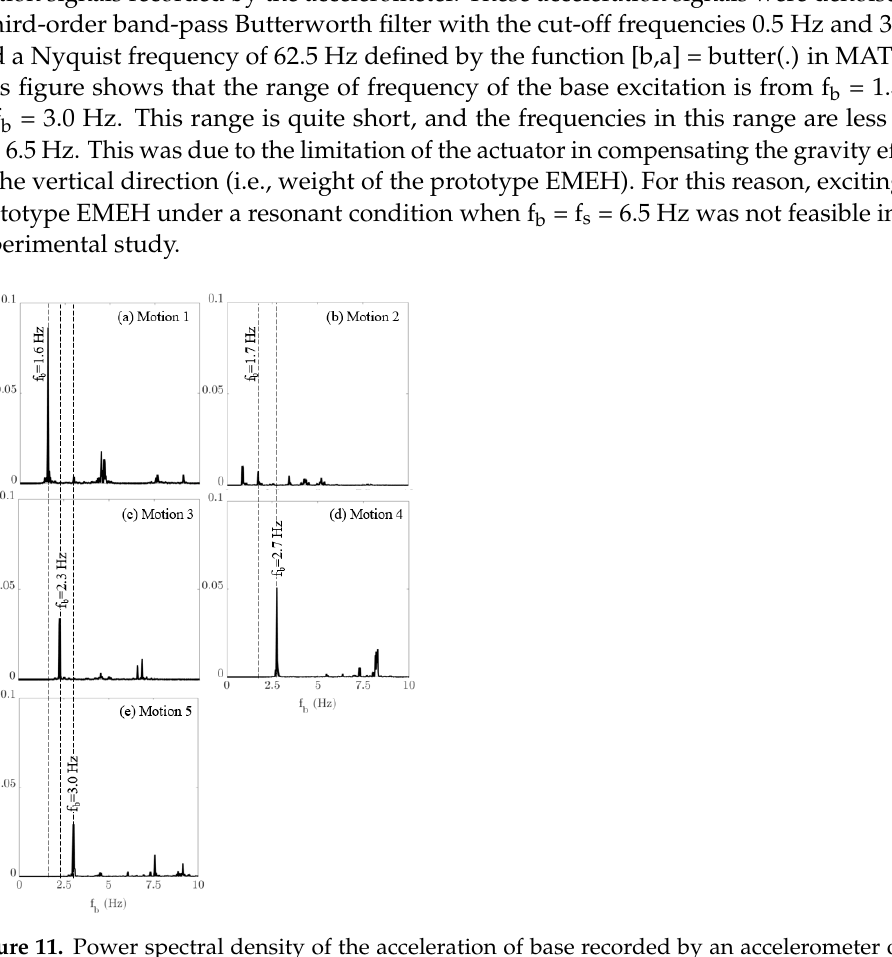
Figure 11. Power spectral density of the acceleration of base recorded by an accelerometer of the model Data Logger